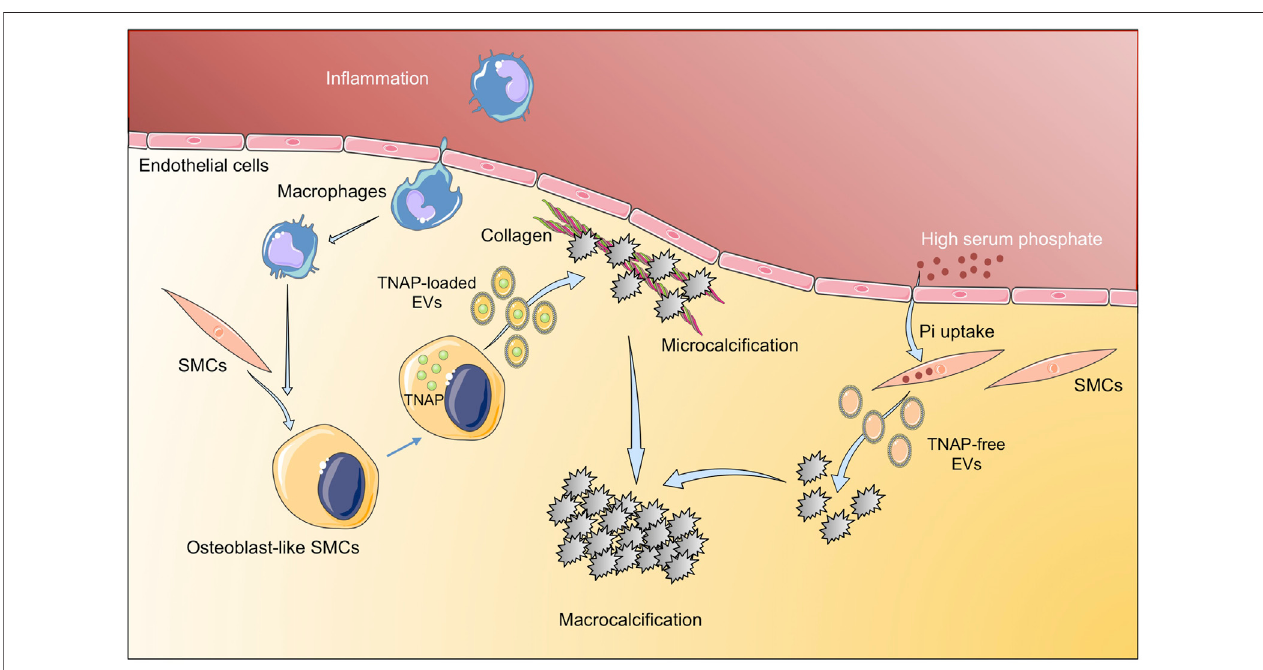
FIGURE 3 | Implication of extracellular vesicles in vascular calci fi cation. In fl ammatory environment induces osteogenic differentiation of SMC to osteoblast-like SMCs that release TNAP-loaded EV that aggregate into microcalci fi cations. In addition, high serum phosphate induces tissue calci fi cation through EV with low TNAP. Figure created using Servier Medical Art images